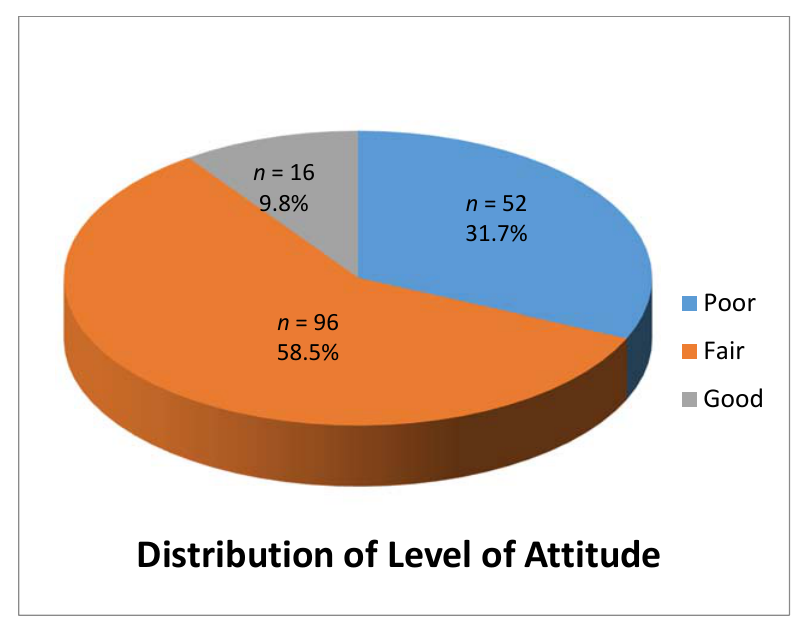
Figure 2. Distribution of level of attitude among the respondents participated in the study.